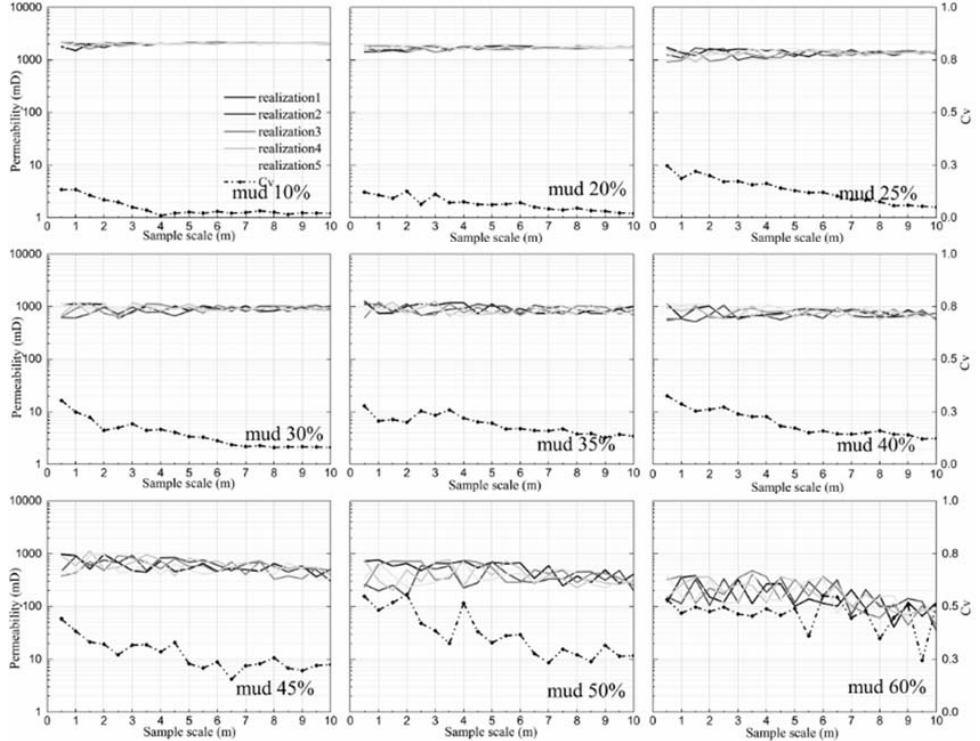
Figure 7. How the horizontal permeability ( k h ) varies with the increase in sample size for ISWZs with constant width. Each solid line is the result of one of the realizations for a certain ISWZ type, and the dotted line represents the Cv value calculated from the five realizations at each scale step.